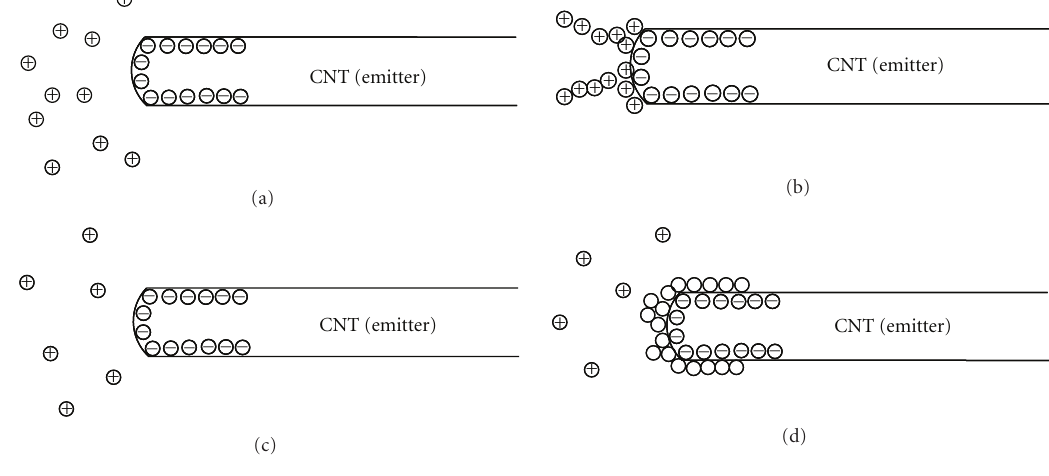
Figure 10: Schematic of nanowire fork growth.